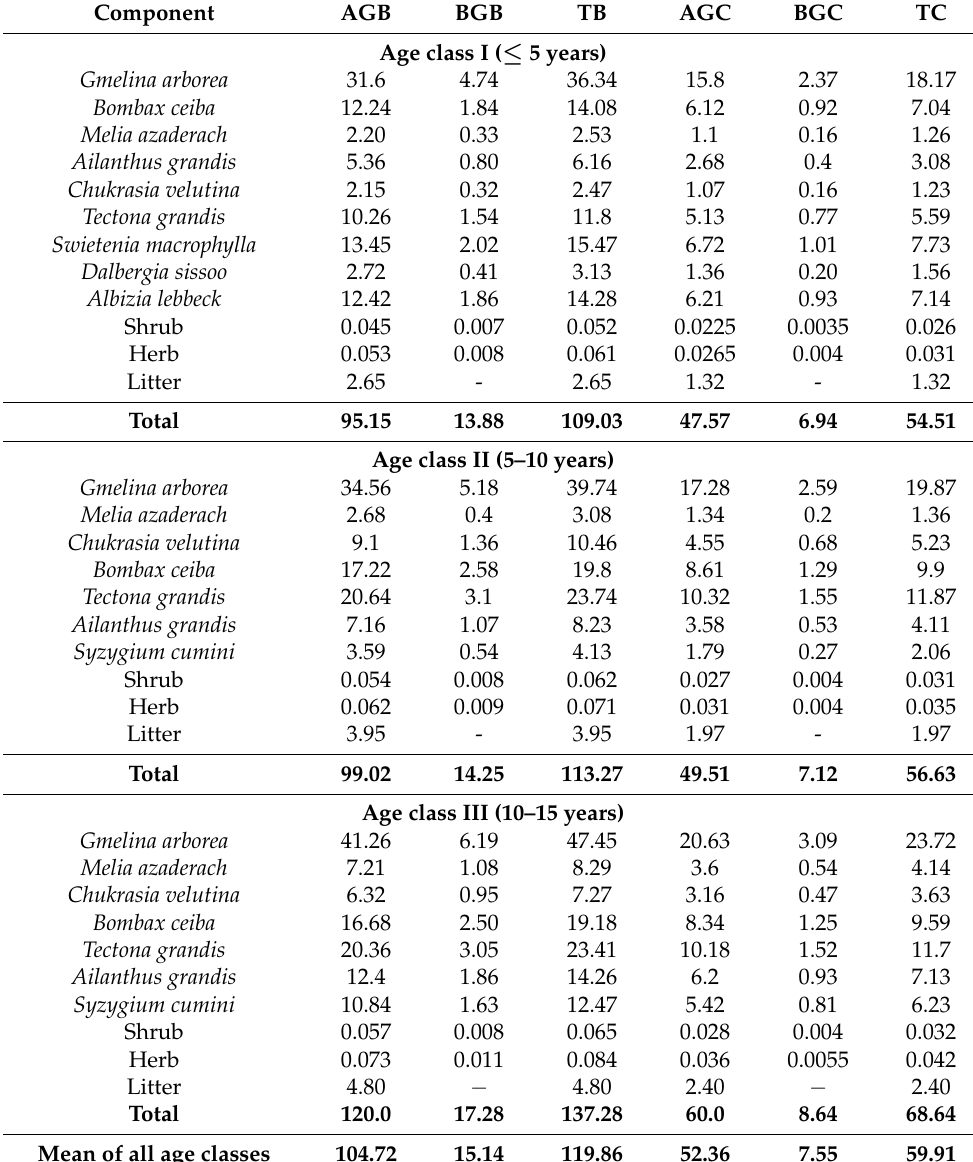
Table 5. Biomass and carbon stock (Mg ha − 1 ) in Gmelina farm forestry